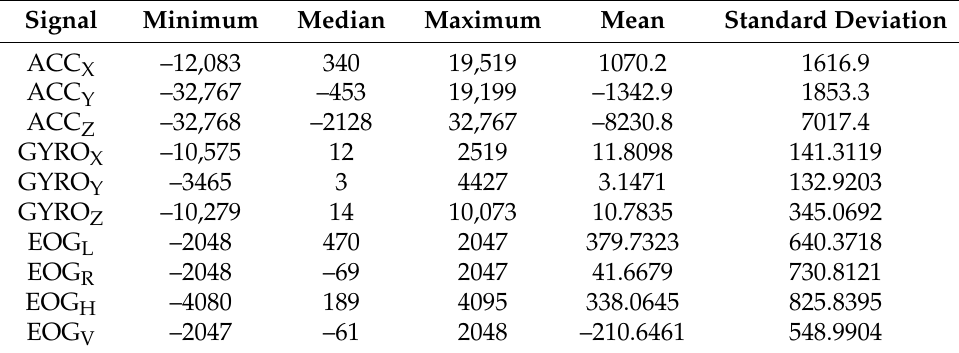
Table 1. Dataset description: general